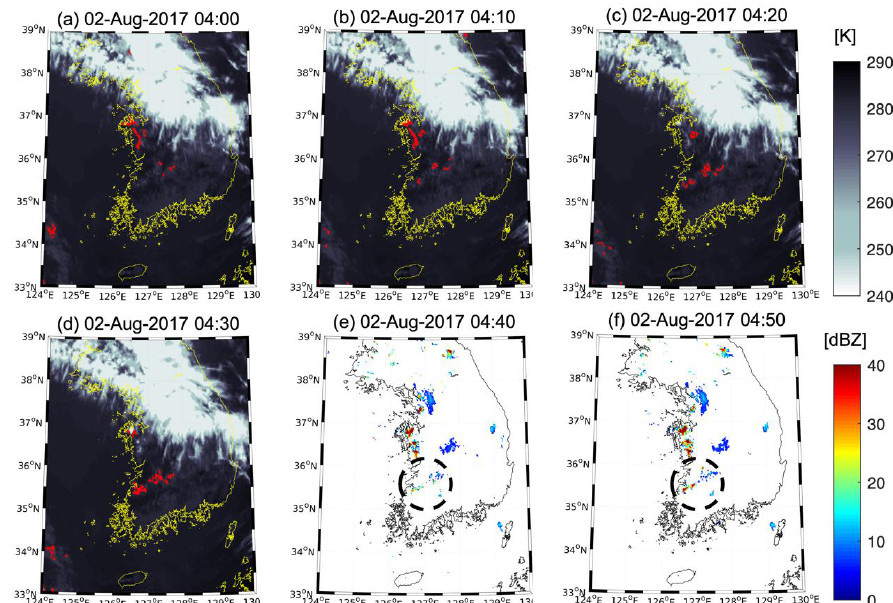
Figure 6. Time series of CI detection results ( a – d ) and radar CAPPI echoes ( e , f ) on 02 August 2017 (CI-C2) from 04:00 to 04:50 after model tuning. In ( a – d ), the predicted CI area is shown in red with T b (11.2) µ m as a background. The area over the target CI events is marked with a black circle in ( e , f ). The first ≥ 35 dBZ of radar echo over the target CI events occurred at 04:50 ( f ).